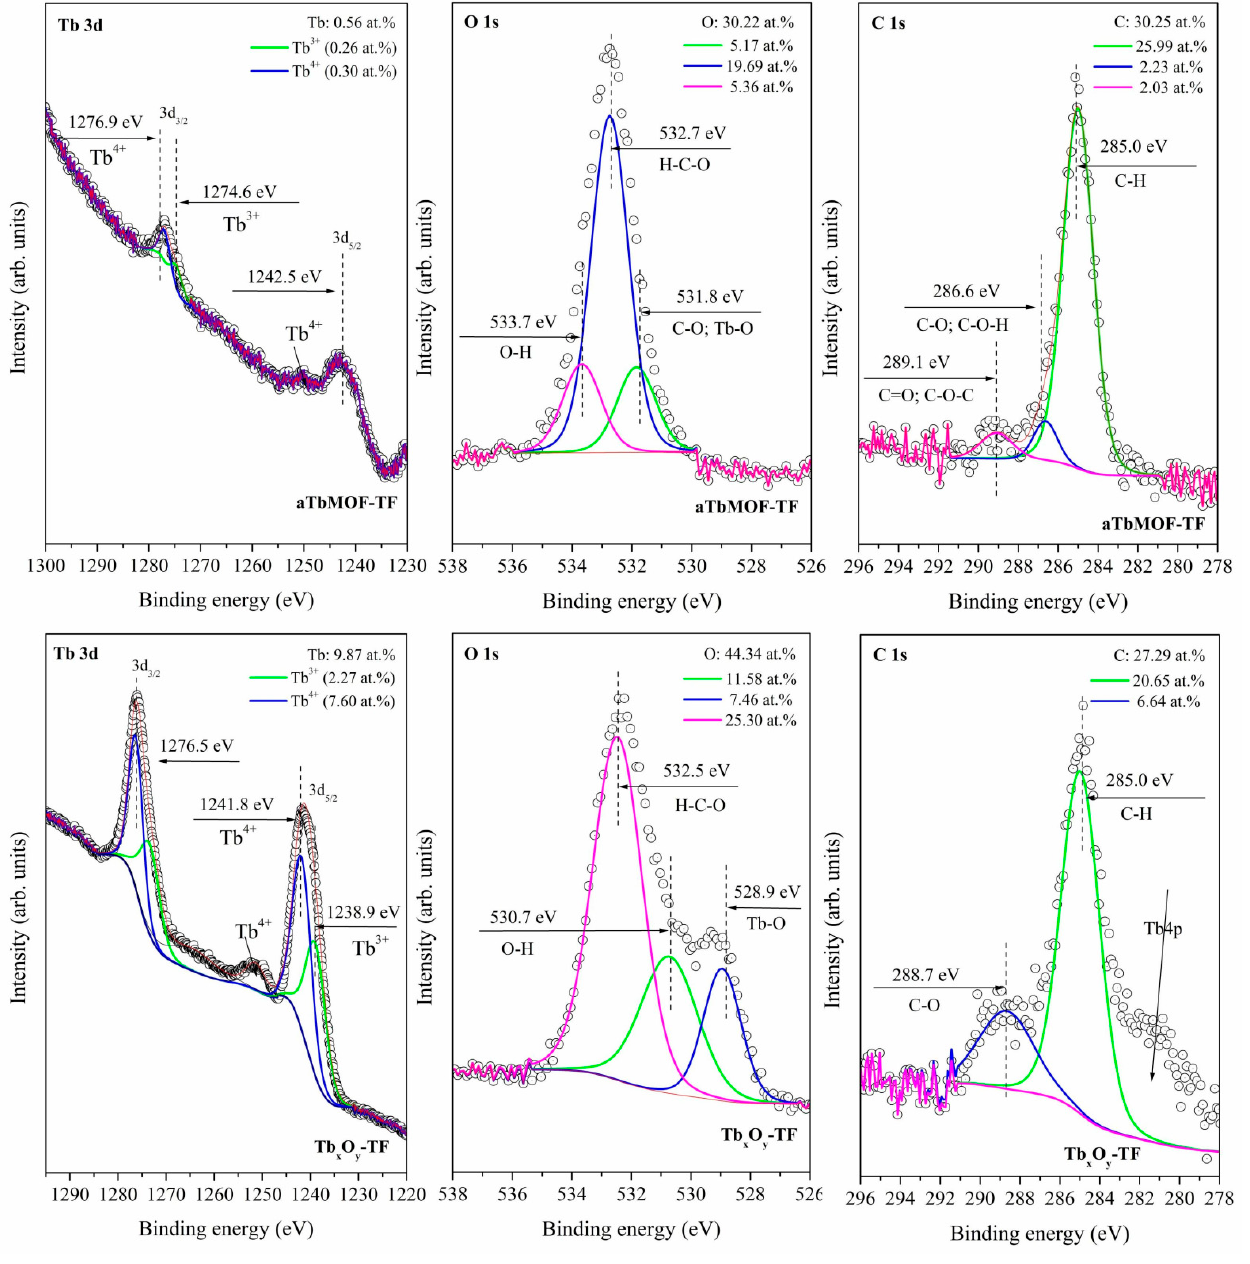
Figure 3. HR XPS spectra of Tb 3d, O 1s, and C 1s for amorphous aTbMOF-TF and terbium oxide Tb x O y -TF thin films.